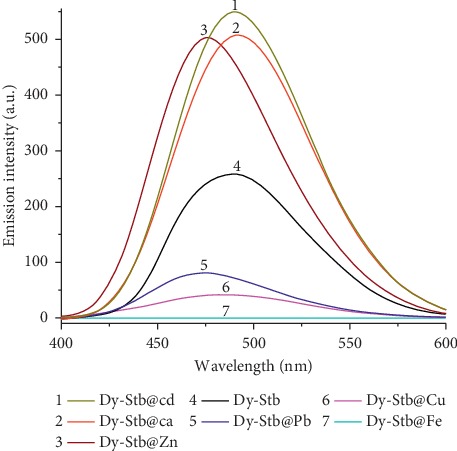
Luminescence emission intensities of different adsorbents: Dy-Stb = Dy2(OH)5(C28H20O6S2)0.5.nH2O.